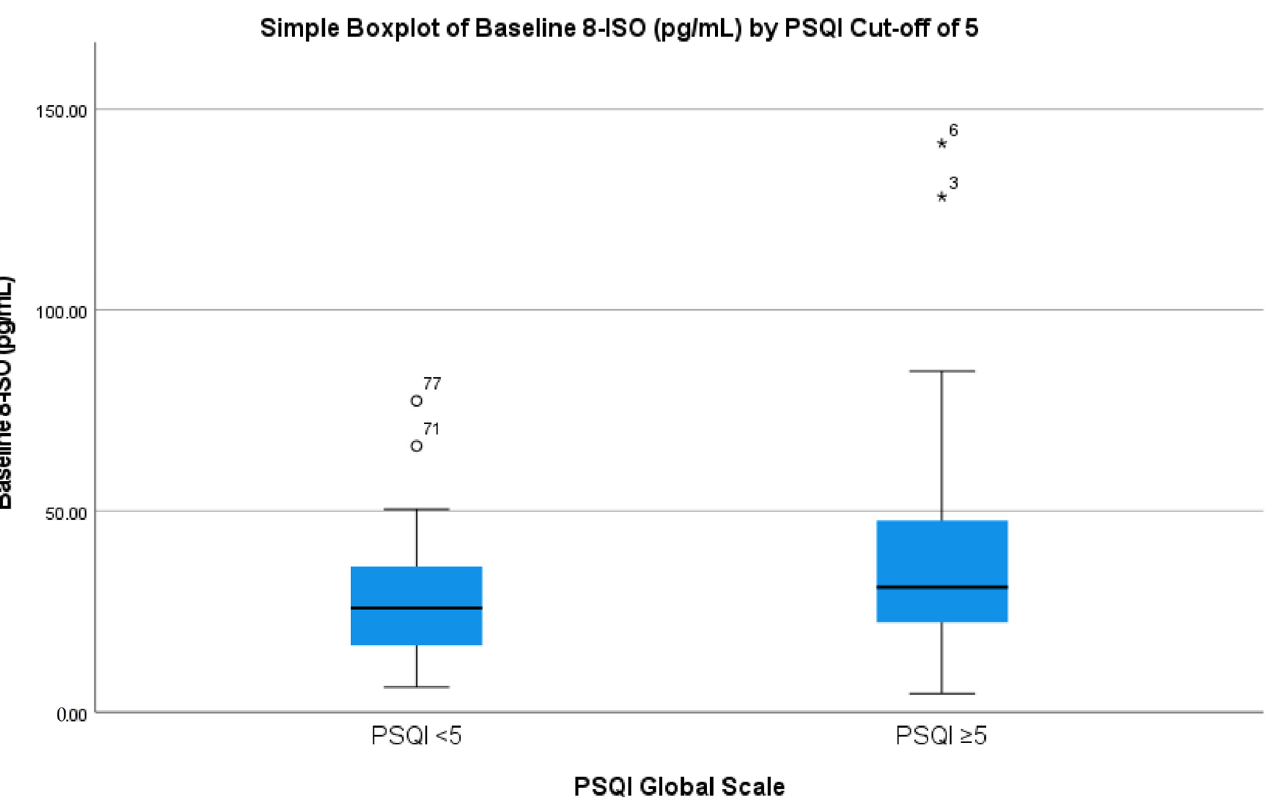
Figure 1. Box plot displaying the median and interquartile range of unadjusted 8-ISO levels in CAD patients with normal and poor sleep (score of at least of 5 on the PSQI scale). Symbols (* and o ) indicate extreme outliers (>3SD). Error bars represent standard error of the